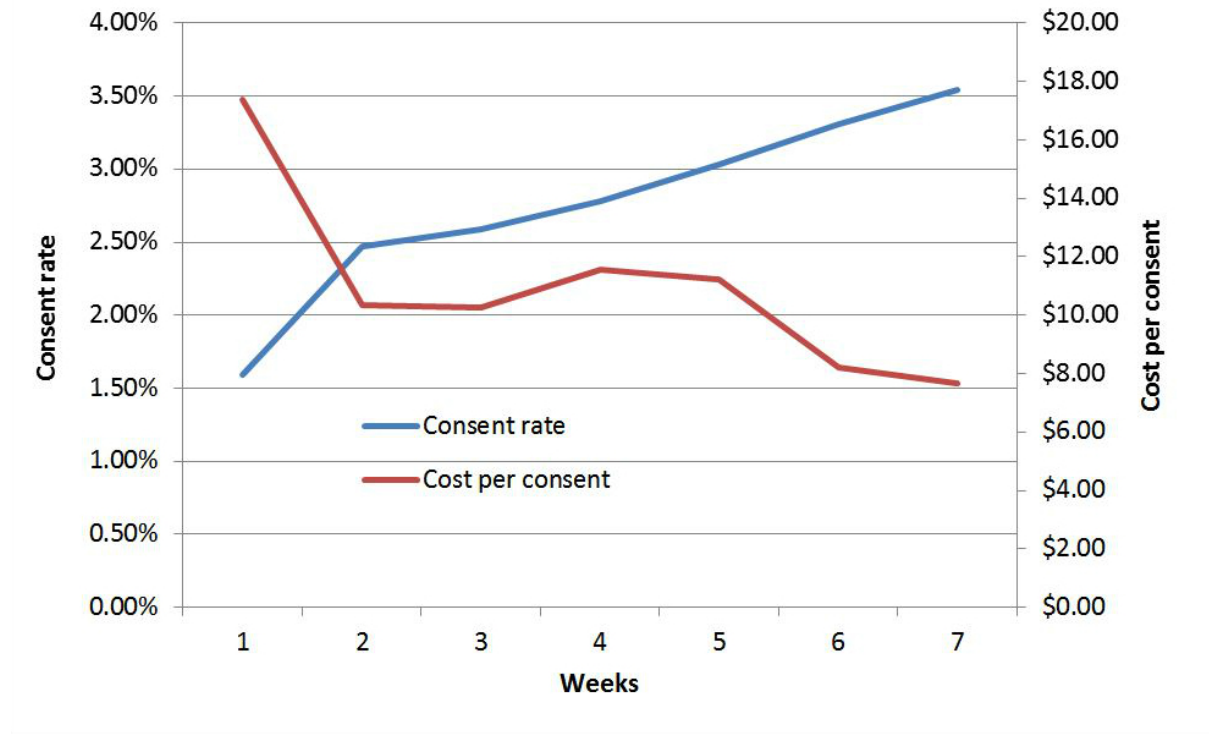
Figure 2. Weekly data on consent rate and per-consent cost during the managed